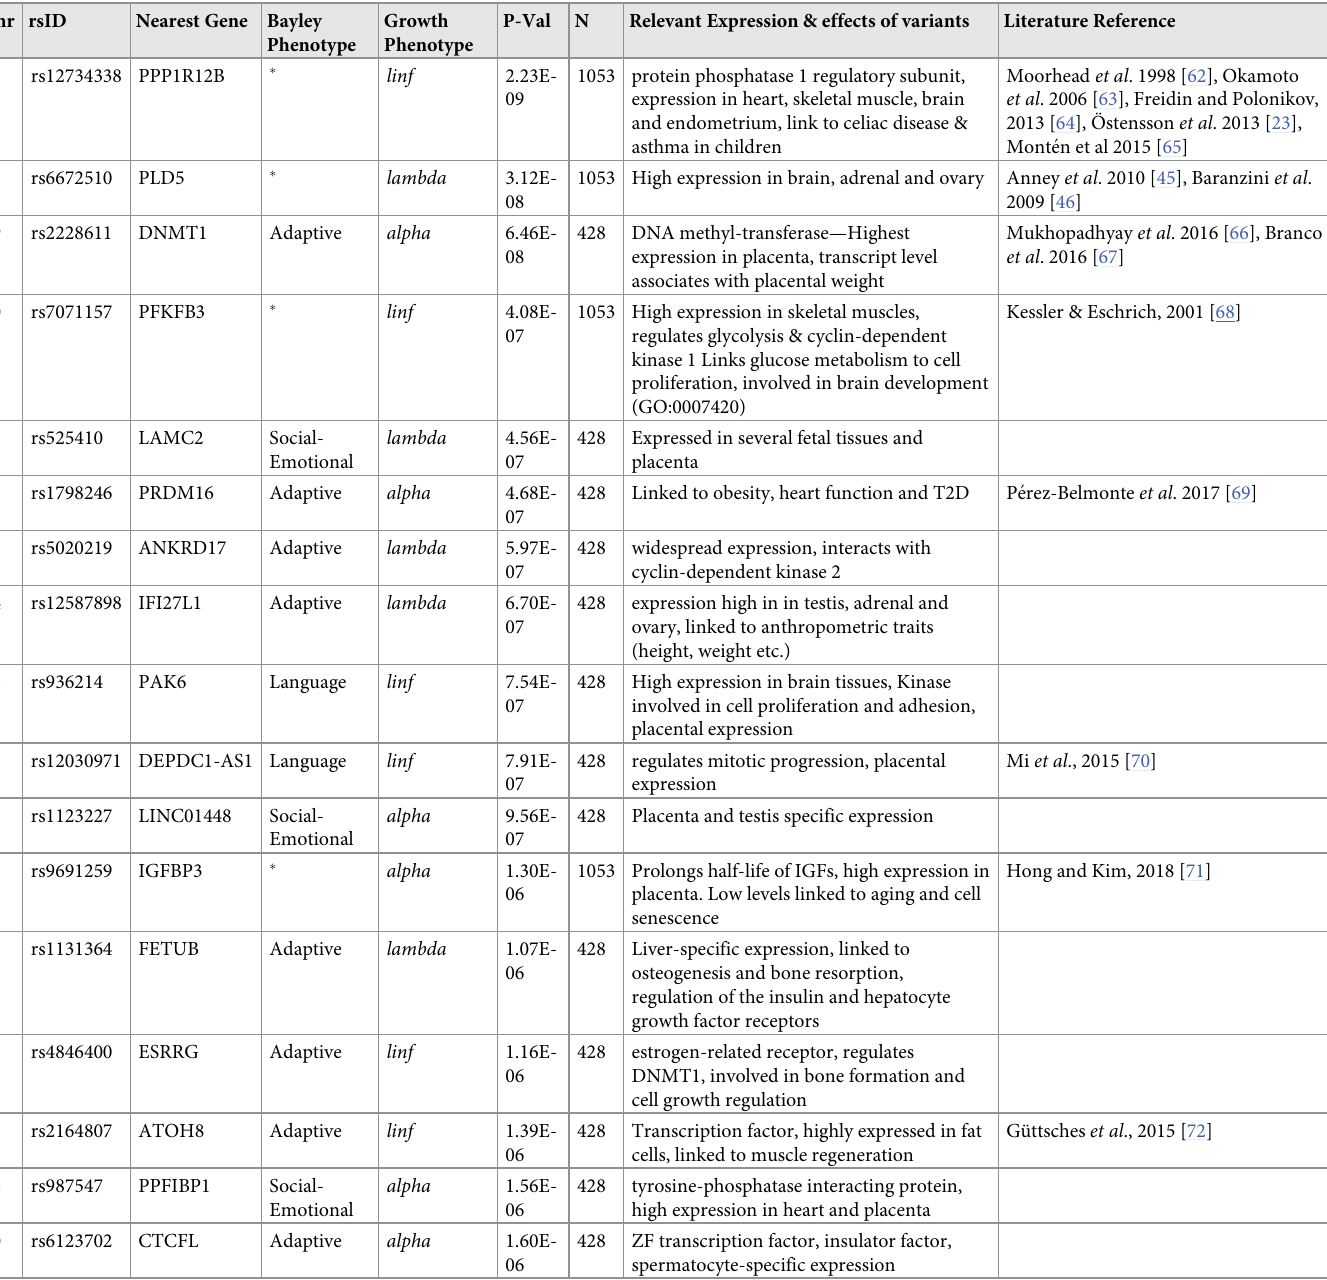
Table 9. Summary of some variants linked to fetal and early childhood development.